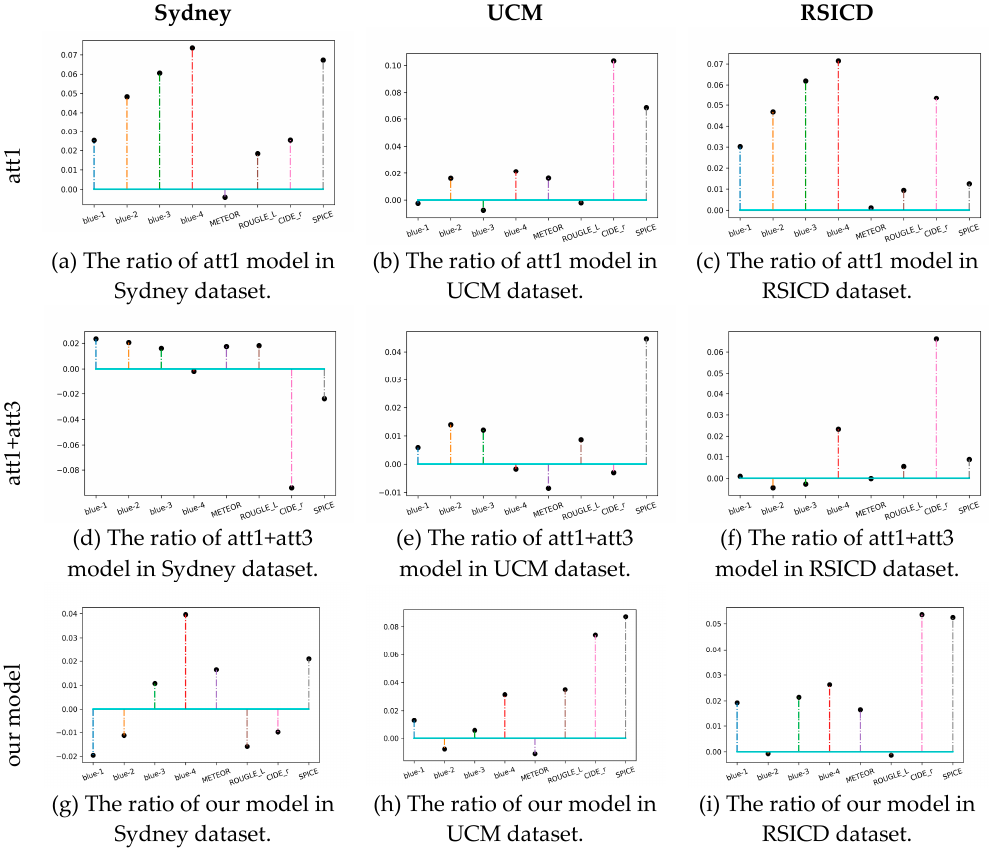
Figure 7. The ratio of model scores increased after datasets were modified. The figure is the result of three models on three datasets, so there are nine sub-figures. Each sub-figure has eight evaluation metrics on the x-axis, and the y-axis value is the ratio, which equals to: (score on modified dataset–score on unmodified dataset) / (score on unmodified dataset). The upward point means that the model scores higher on the modified dataset than the unmodified dataset.